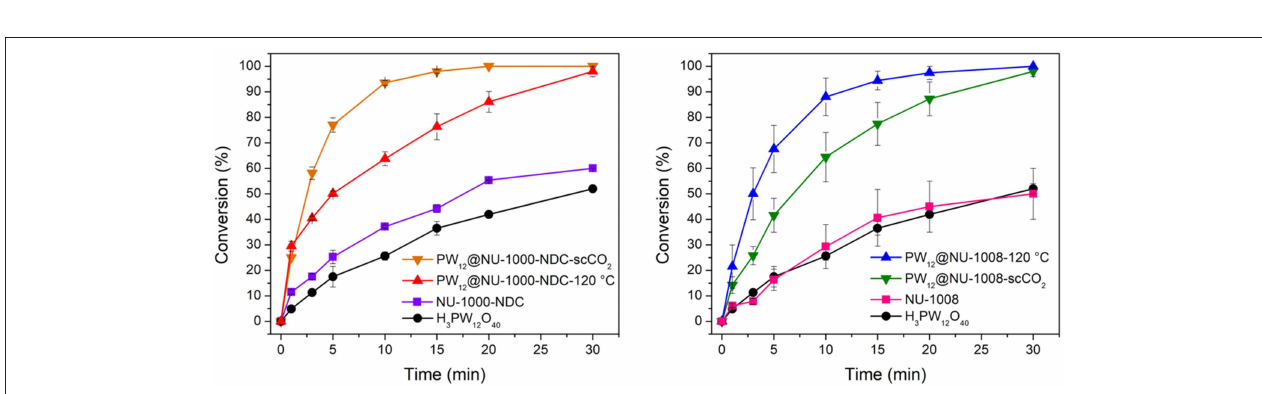
FIGURE 6 | CEES conversion over time with (Left) NU-1000-NDC and its POM composites and (Right) NU-1008 and its POM composites. Error bars represent standard deviation of at least 2 trials.